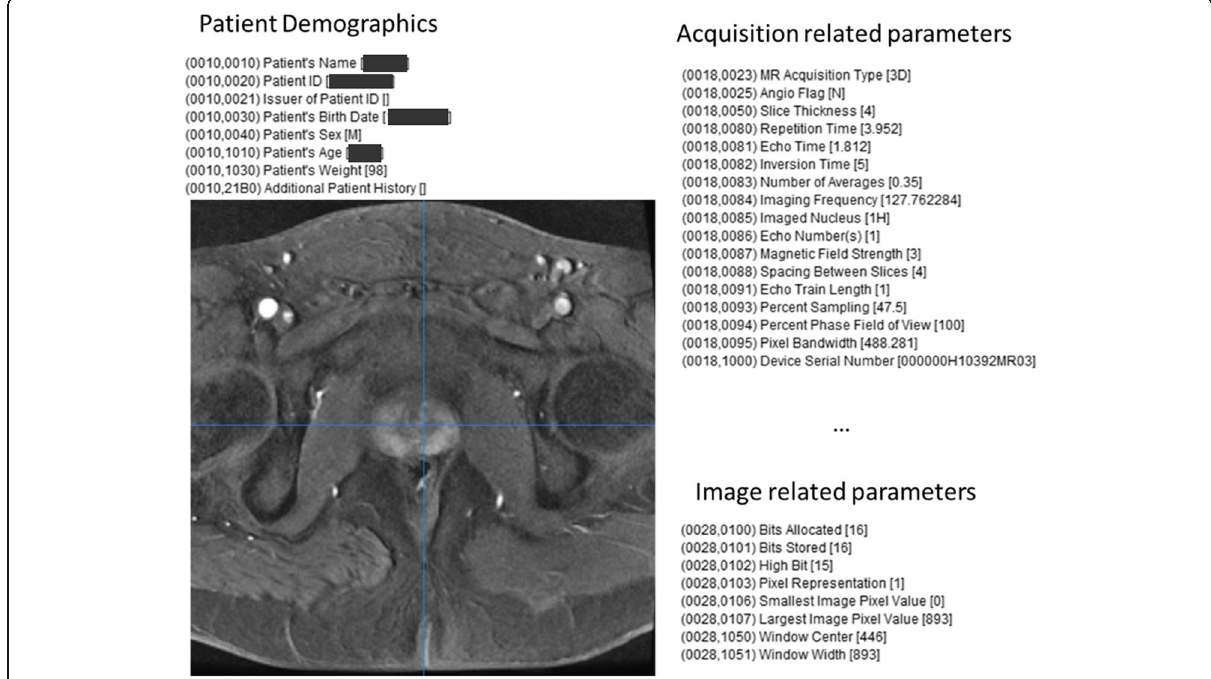
Fig. 1 An example of a Digital Imaging and Communications in Medicine (DICOM) contrast-enhanced magnetic resonance image (T1-weighted sequence) of the prostate and DICOM metadata about patient demographics, acquisition-related parameters and image-related